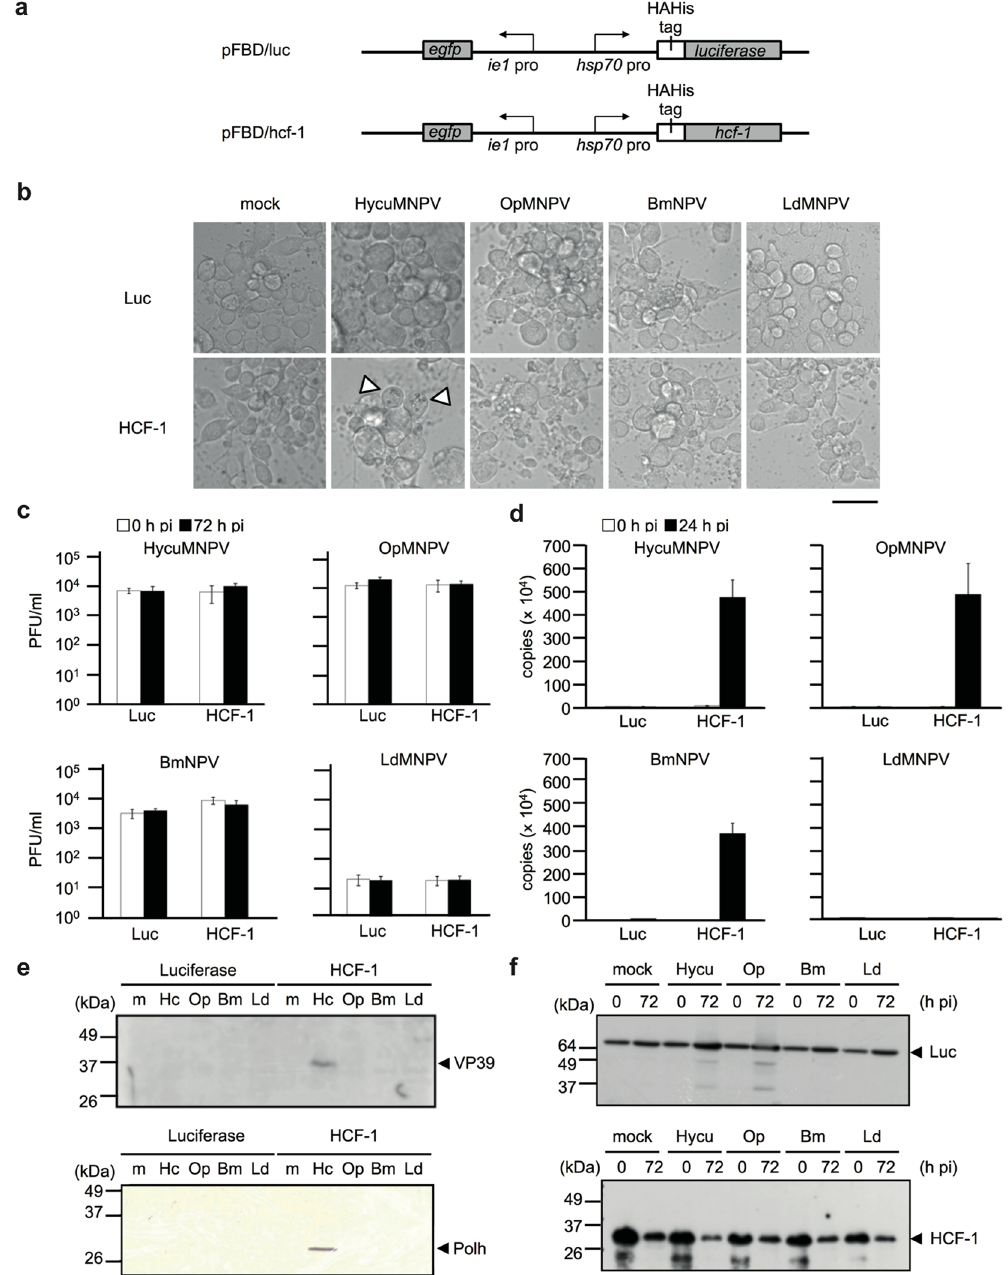
Figure 1. Transiently expressed HCF-1 protein promotes the synthesis of NPV DNA and proteins in non- permissive Tn368 cells. Tn368 cells were transfected with 2 μ g of pFBD/luc (Luc) or pFBD/hcf-1 (HCF-1) DNA, which express luciferase or HCF-1 protein, respectively, under control of the heat shock protein 70 promoter ( hsp70 pro). At 24 h post-transfection, the transfected cells were heat-shocked at 42 °C for 30 min, incubated for 6 h at 28 °C, and were then infected with HycuMNPV (Hycu), OpMNPV (Op), BmNPV (Bm) and LdMNPV (Ld) at MOIs of 10, 50, 10 and 3, respectively. ( a ) Schematic representation of the plasmids pFBD/ luc and pFBD/hcf-1 used in these experiments. ( b ) Microscopic images of Tn368 cells at 72 h post-infection. The arrowheads indicate polyhedra-containing cells. Scale bar, 50 μ m. ( c ) BV yields in virus-infected Tn368 cells at 72 h post-infection (pi). BV titers were determined by a plaque assay using SpIm cells for HycuMNPV, BM-N cells for BmNPV and Ld652Y cells for OpMNPV and LdMNPV. The vertical bars represent the standard deviations of the averages from three determinations. ( d ) Viral DNA production at 24 h post-infection. Viral DNA was quantified by qPCR. The vertical bars represent the standard deviations of the averages from three determinations. ( e ) Immunoblot analysis of VP39 and polyhedrin (Polh) proteins at 72 h post-infection. Polypeptides from infected Tn368 cells were resolved on 12% SDS-polyacrylamide gels and transferred onto Immobilon-P (for VP39 protein) or nitrocellulose membranes (for polyhedrin). VP39 protein was probed using anti-BmNPV/AcMNPV VP39 polyclonal antibody and visualized with ECL Select Western Blotting Detection Reagent. Polyhedrin protein was probed with anti-BmNPV polyhedrin polyclonal antibody and